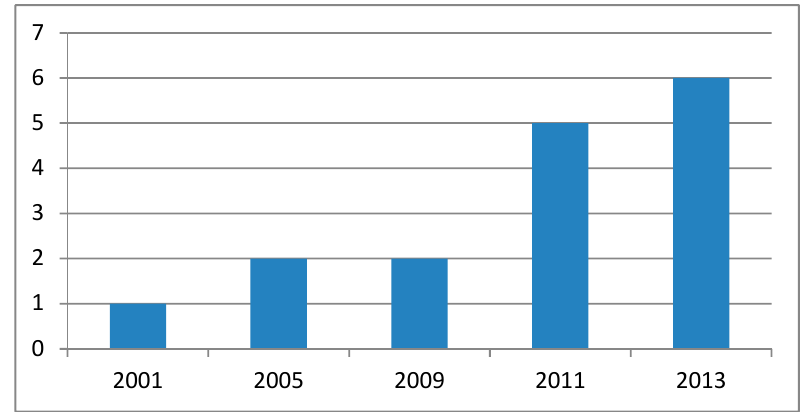
Figure 4. Number of papers presented at Latin-Ibero-American Association of Technology Management (ALTEC).